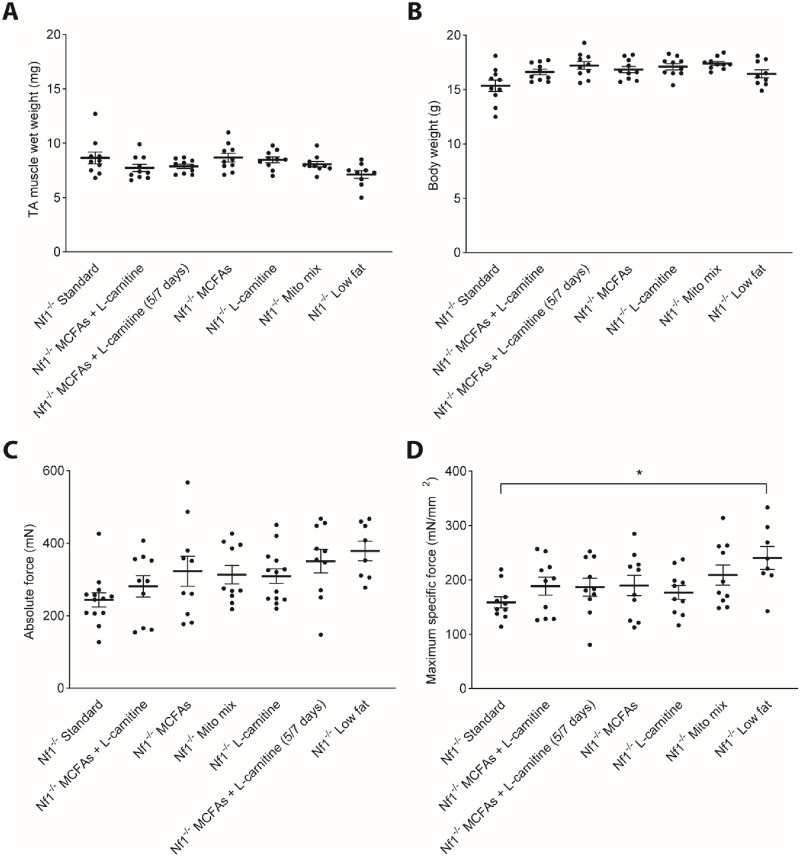
Nf1Prx1-/- mice fed a low fat diet have increased maximum specific force without change to TA muscle wet weight.(A) TA muscle wet weight and (B) Body weight remained unchanged following 8 weeks of dietary treatment. (C-D) Low fat feeding resulted in a 66% increase in maximum specific force compared with Nf1Prx1-/- fed standard chow. N = 10 in situ TA muscles per group. Data presented as group mean ± SEM. p-values were assessed by one way ANOVA. *p <0.02.